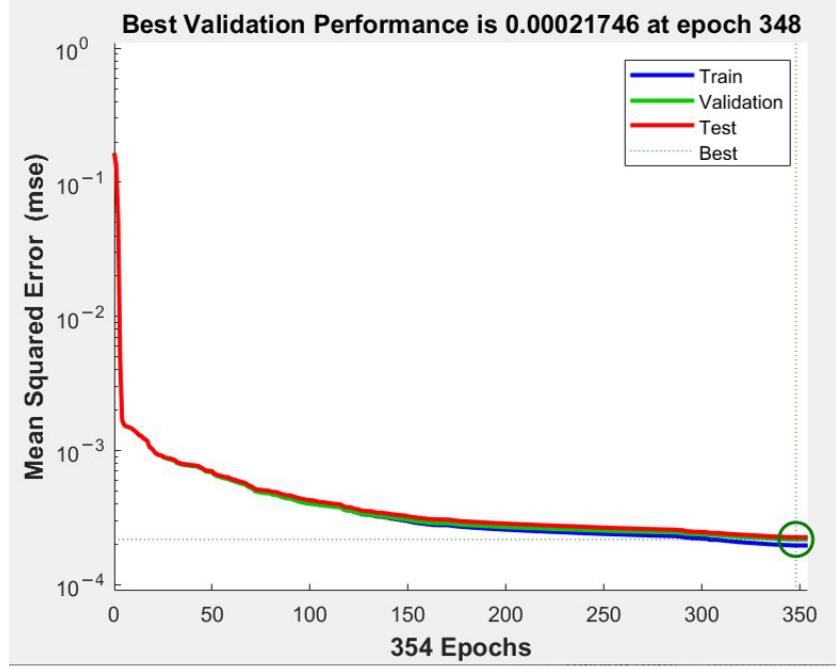
Figure 7. The relation between number of epochs and training MSE.